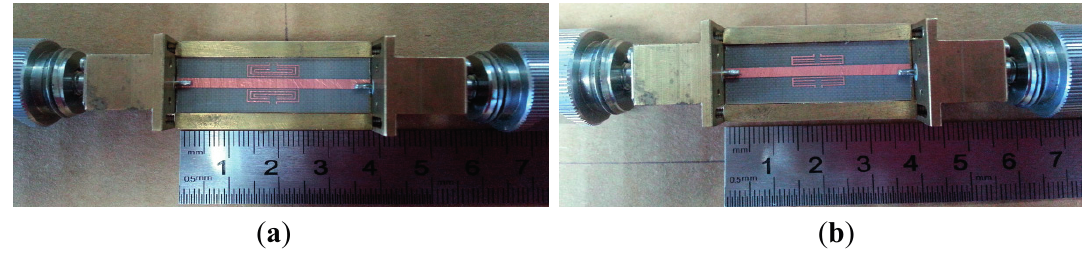
Figure 5. Photograph of the fabricated sensors: ( a ) aligned-gap; ( b ) centered-gap.